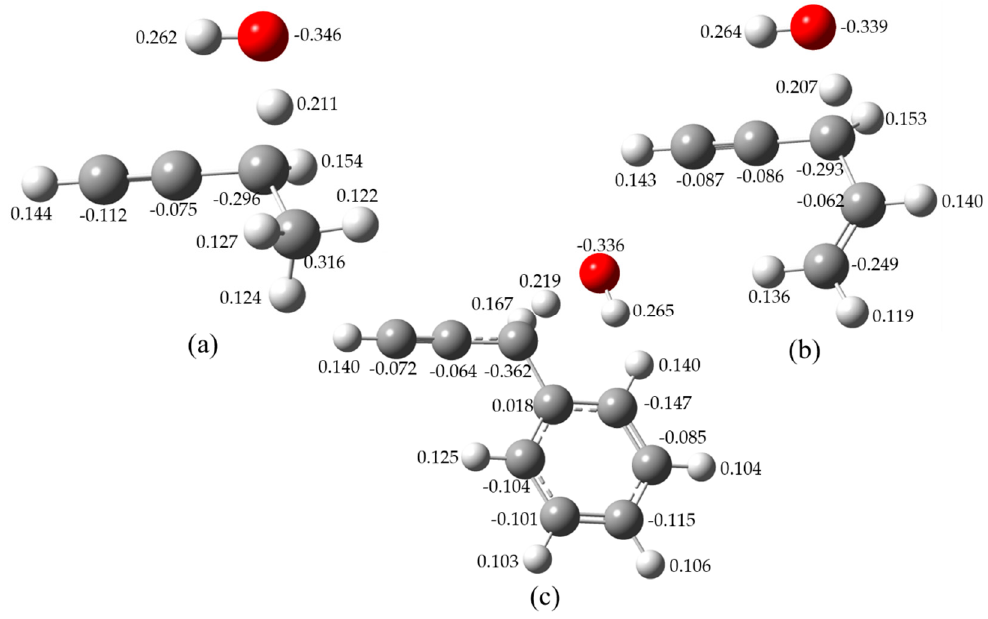
Figure 4. Mulliken charge distributions of the TSs for 1-butyne ( a ), 4-penten-1-yne ( b ), and 3-phenyl-1- propyne ( c ) with OH, respectively.